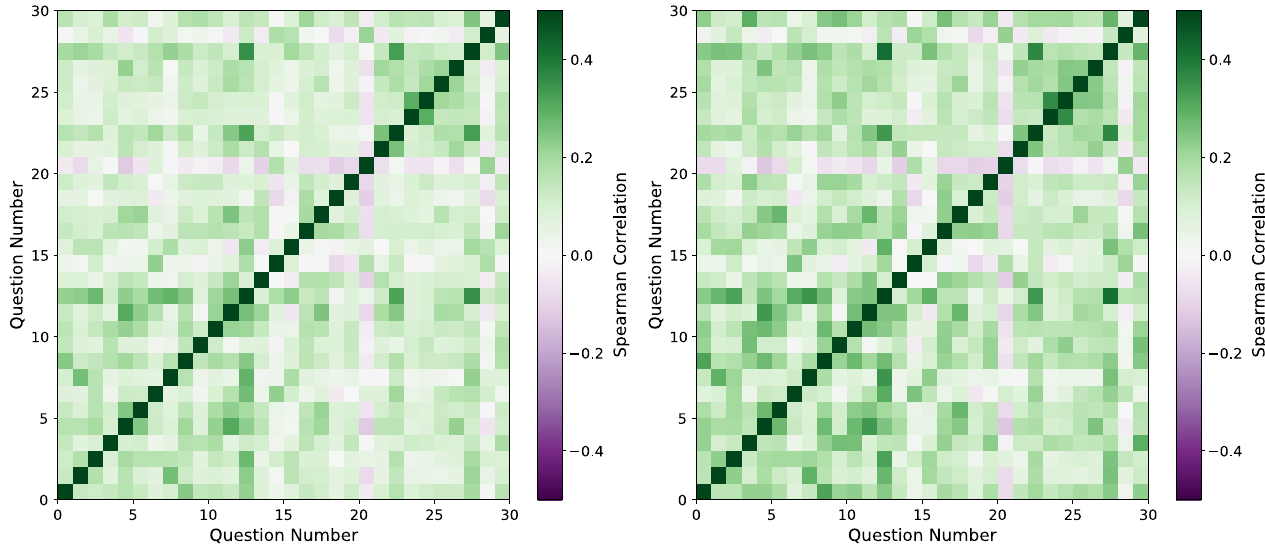
FIG. 5. Spearman correlation coefficients for the E-CLASS survey questions. The left panel shows the presurvey correlations. The right panel shows the postsurvey correlations. Data have not been separated between introductory and BFY students. Instead, they are combined across both groups. If questions measured similar constructs, there would be a high ( ρ > 0 . 5 ) correlation between different questions. This is not the case for either the pre-